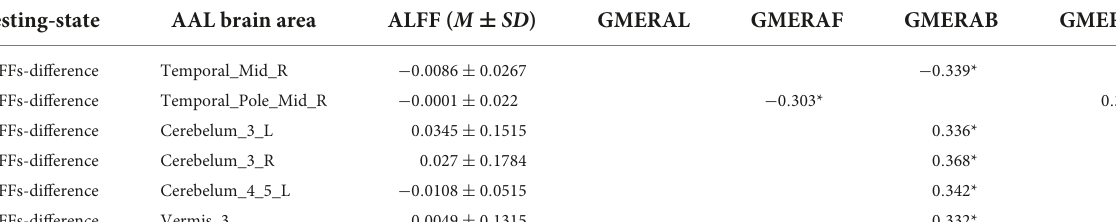
FIGURE2 The ALFFs-relevant brain areas of the GMERA.